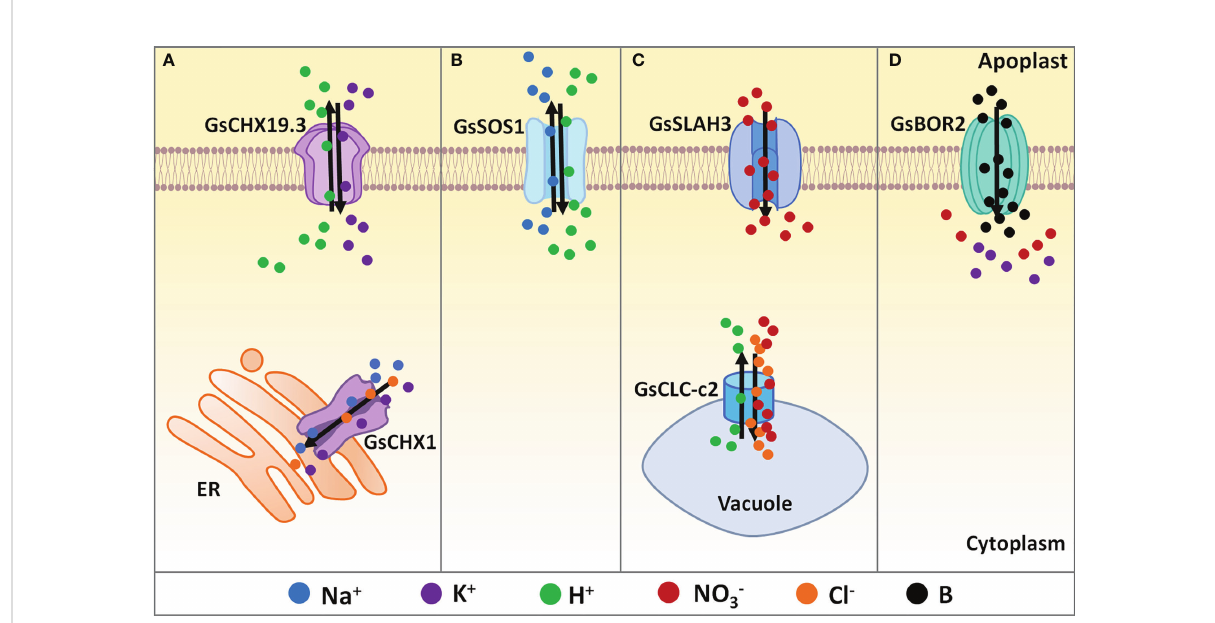
FIGURE 1 Regulation of ion balance under salt-alkaline stress in wild soybean. (A) Cation/H + exchangers, (B) Na + /H + antiporters, (C) Anion channels, (D) Boron transporters identi fi ed in G. soja involving in ion balancing under salt-alkaline stress. ER, endoplasmic reticulum. Solid dots with different colors represent different types of ions. Black arrows mean the direction of ion fl ow across the